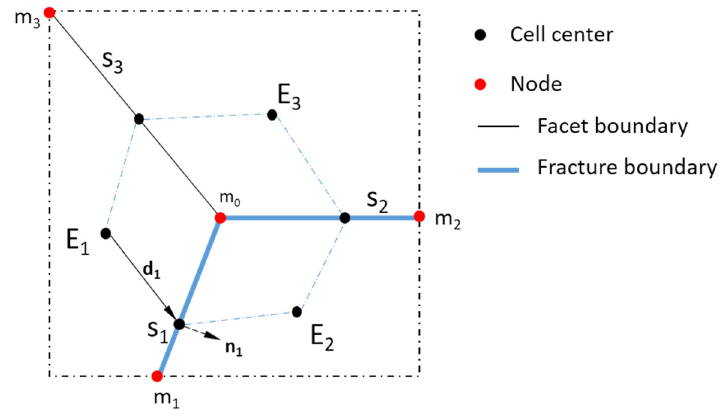
Figure 3. Schematically shown matrix and fractures represented by Discrete Fracture Model